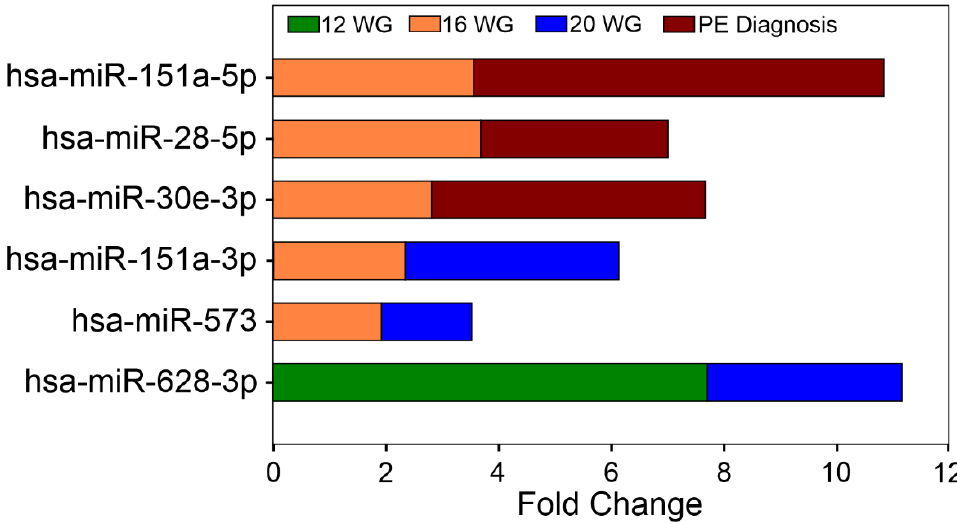
Figure 3. Differentially expressed miRNAs between the groups in at least two of the pregnancy time points evaluated.